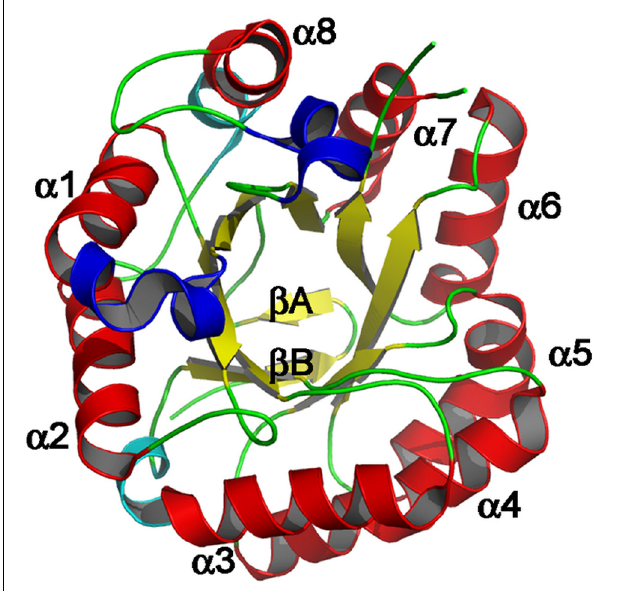
FIGURE 2 | Schematic representation of modular structure of β -mannanase, displaying the Tim barrel structure. Major α -helices are colored red while β -strands are shown as yellow, labeled in accordance with the ideal ( β / α )8 barrel structure. Adopted with permission from Zhao et al.